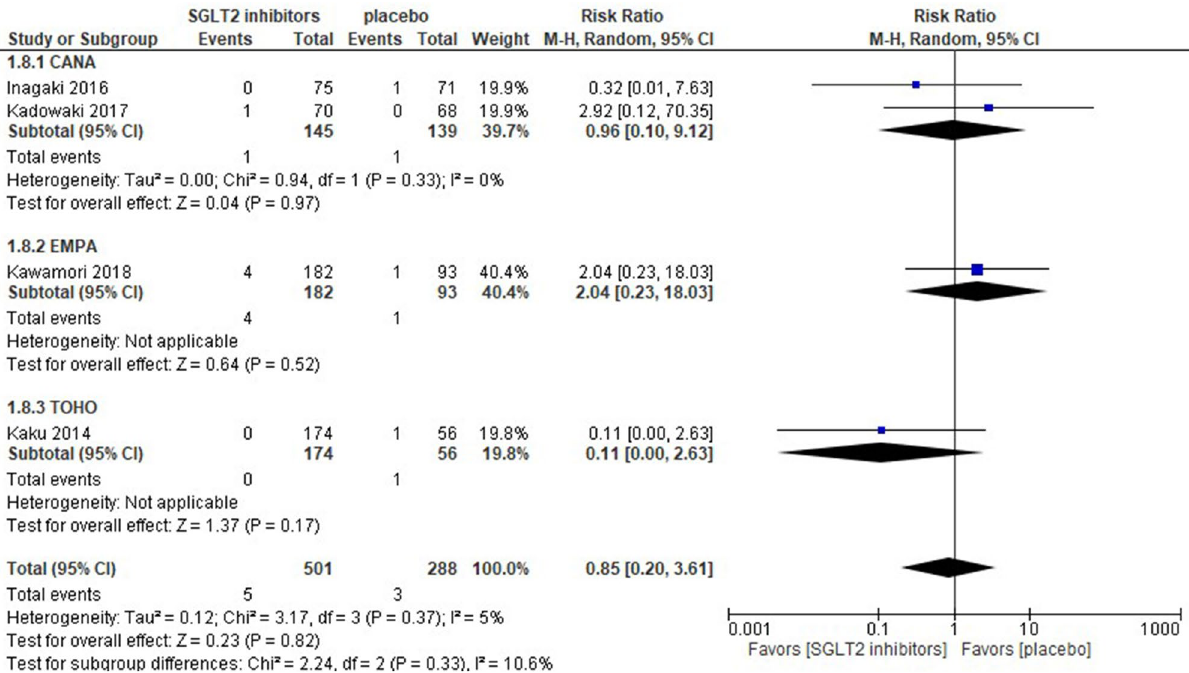
Figure 5. Forest plot for the risk of fracture. CANA canagliflozin, EMPA empagliflozin, TOFO tofogliflozin, SGLT2 sodium-glucose co-transporter